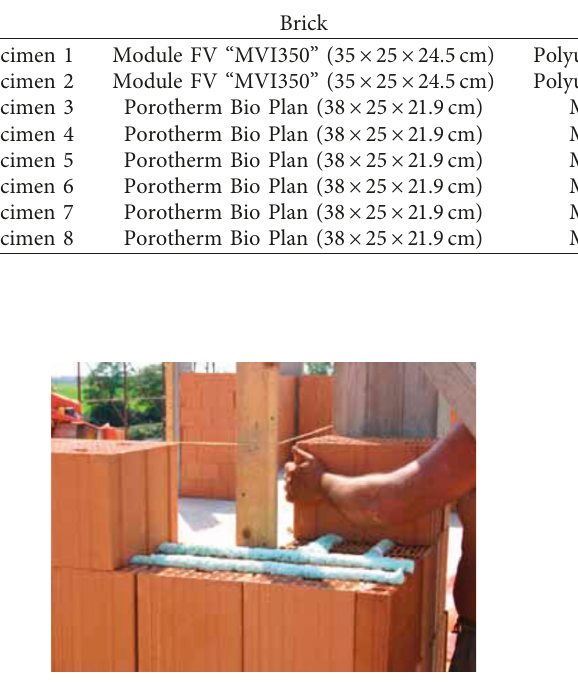
Figure 17: Example of foam placement on the brick.